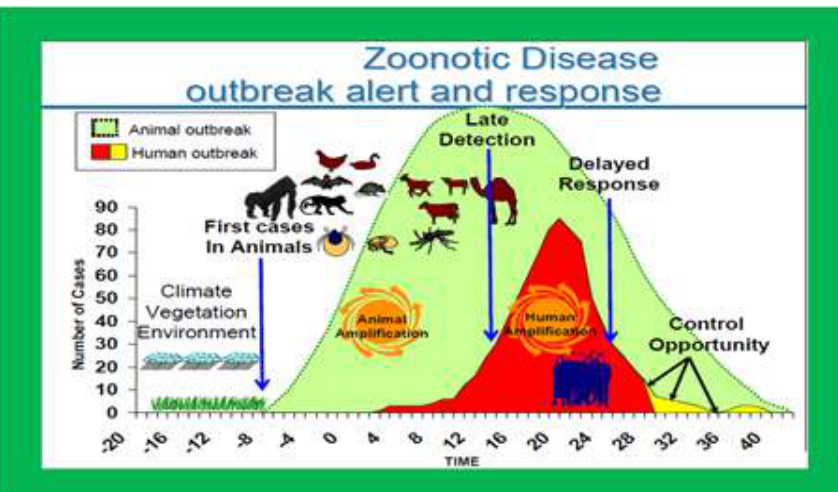
Figure-2. GIS-GLEWS approach for prediction of zoonotic Diseases